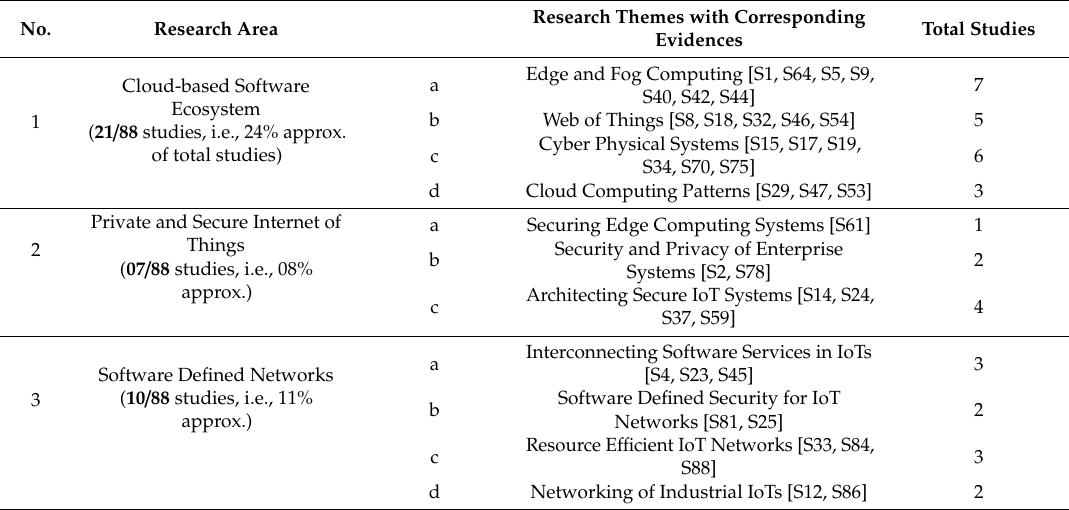
Figure 7. Taxonomical Classification of Research on Architecting Software for the Internet of Things. Table 4. Research themes, sub-themes, and corresponding evidences (published research